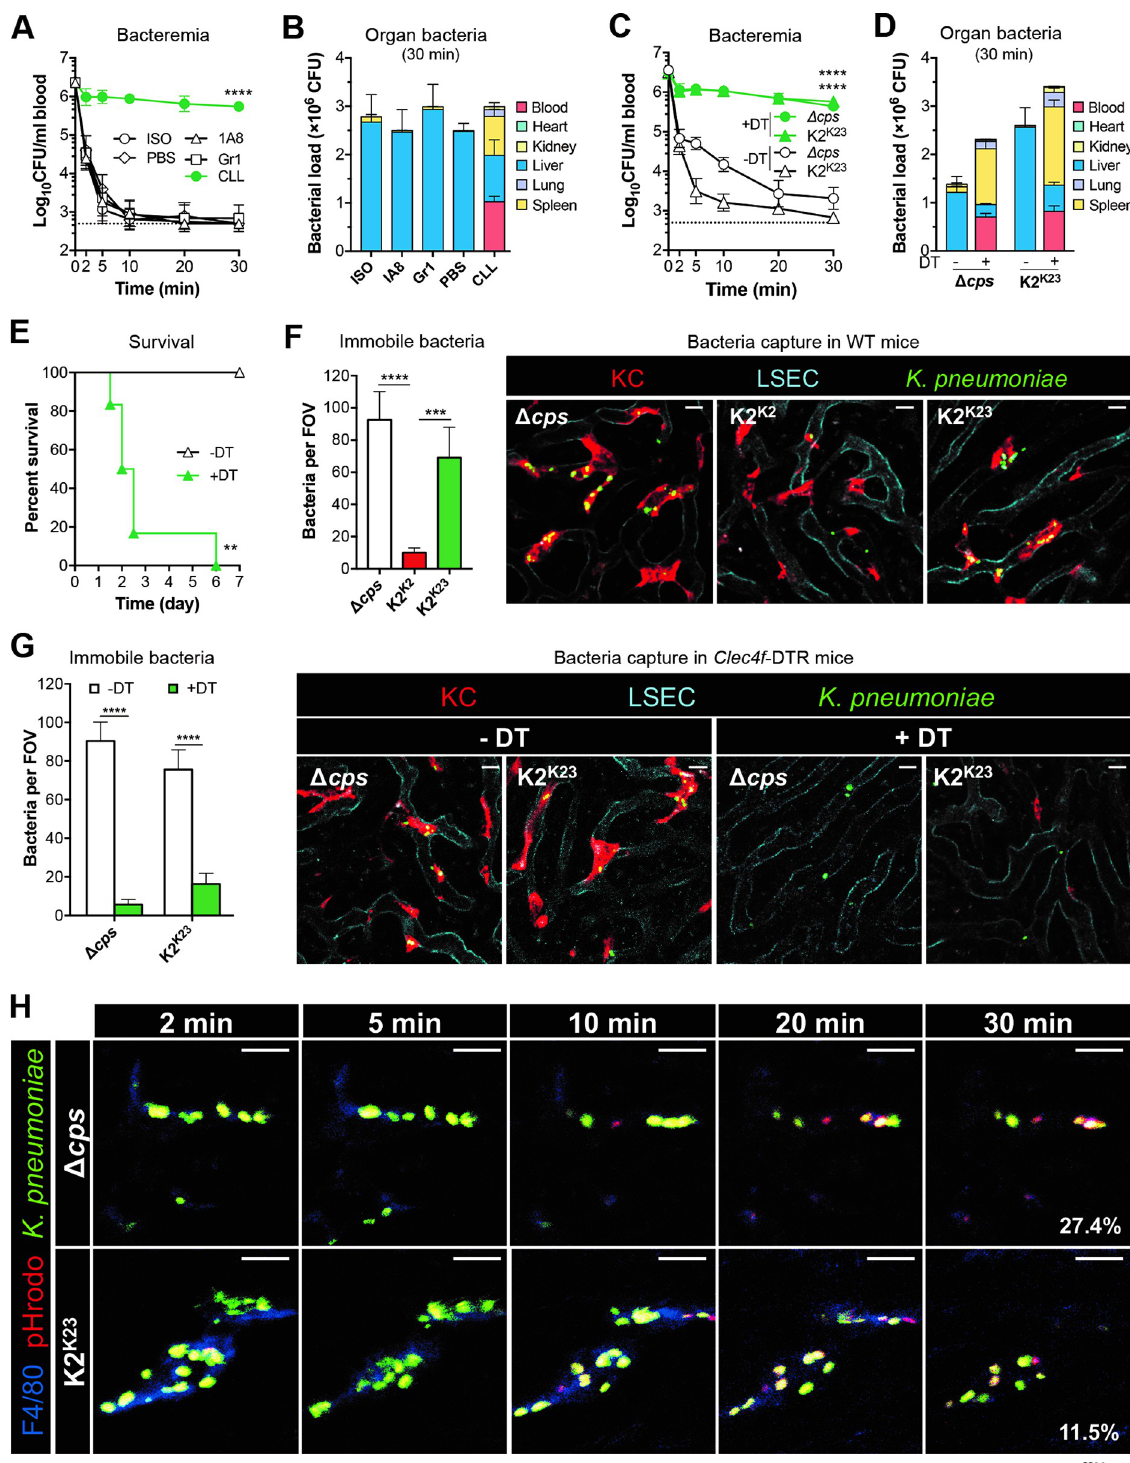
Fig 5. Capsule type-dependent capture of K . pneumoniae by KCs. A, B. Importance of macrophages in clearing the LV derivative (K2 K23 ) of ATCC43816. CD1 mice were pretreated with PBS, ISO (isotype control), CLL (depleting macrophage), 1A8 antibody (depleting neutrophil) or Gr1 antibody (depleting neutrophil and inflammatory monocyte) before being i.v. infected with 5 × 10 6 CFU of K2 K23 to determine bacteria in the bloodstream ( A ) and organs ( B ). n = 6. C, D. Essentiality of KCs in capturing acapsular and LV variants of ATCC43816. Clec4f -DTR mice were pretreated with (+DT) or without (-DT) diphtheria toxin and i.v. infected with 5 × 10 6 CFU of the